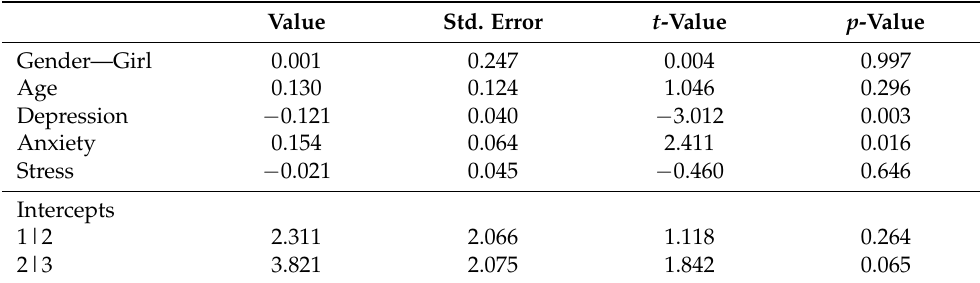
Table 3. Multinomial ordinal regression for self-esteem.